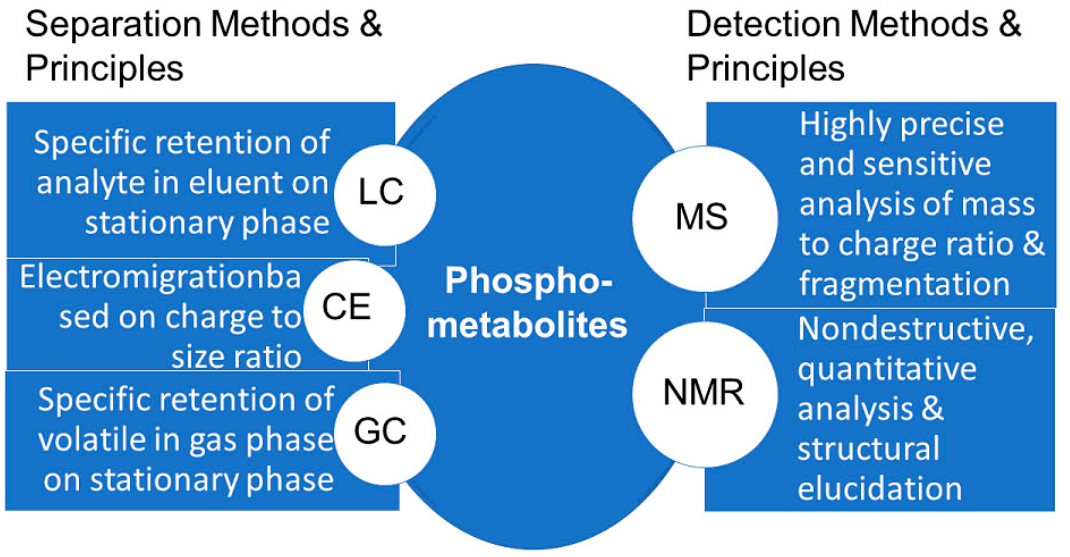
Figure 13. Summary of methods and principles for the analysis of phosphometabolites.